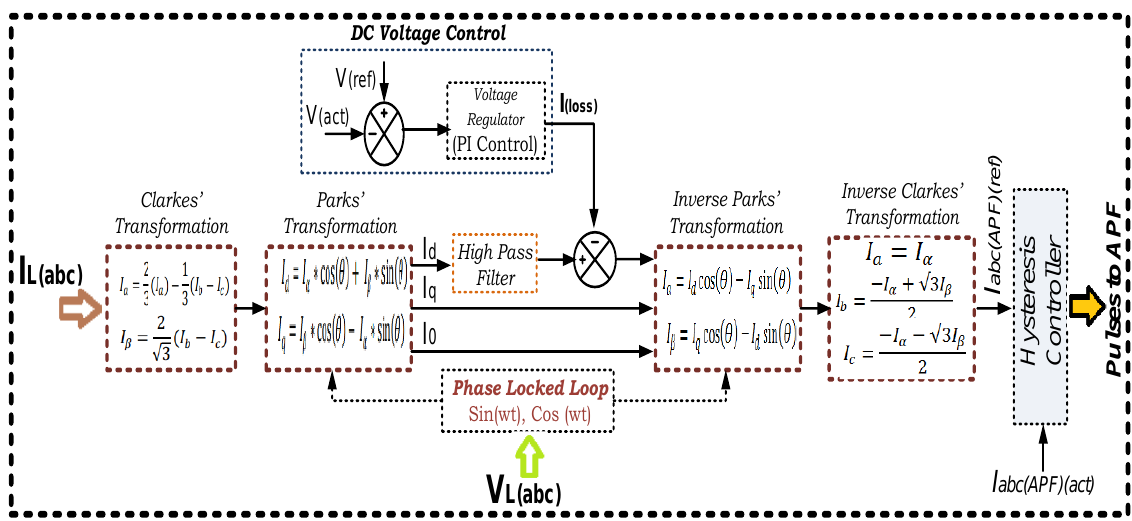
Figure 3. d-q reference theory for compensation of harmonics